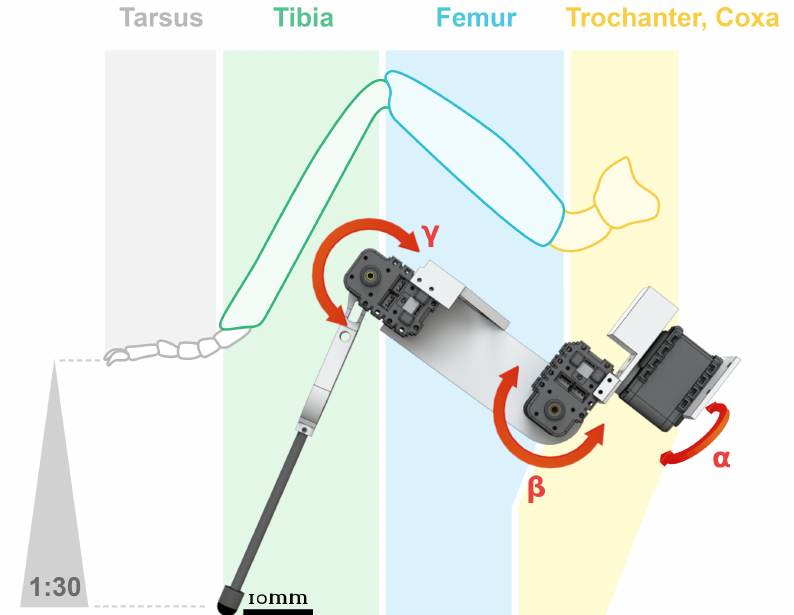
Figure 2. A standard hexapod robot 3-DOF leg, based the Cataglyphis fortis ant scale 1:30. Angle α corresponds to the thorax-coxa joint position, angle β corresponds to coxa-femur joint (up to now, robotic designs have often fused the trochanter-femur joint), and angle γ represents femur-tibia position. Illustration: ©Camille Dégardin & Ilya Brodoline